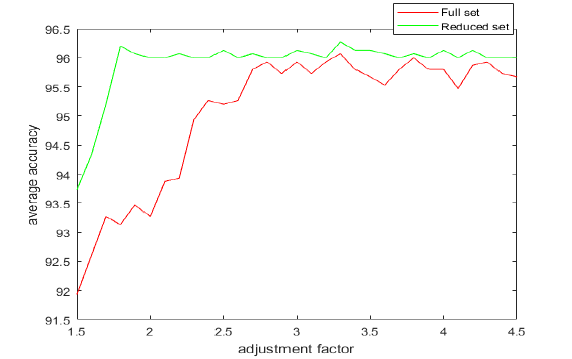
Figure 9. The average accuracy versus the adjustment factor for the full and the reduced Iris